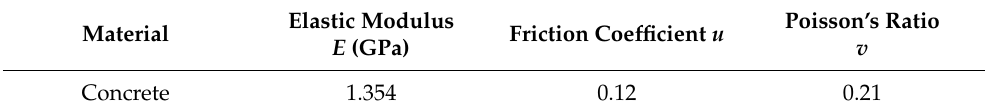
Table 4. Mechanical parameters used in numerical modeling.